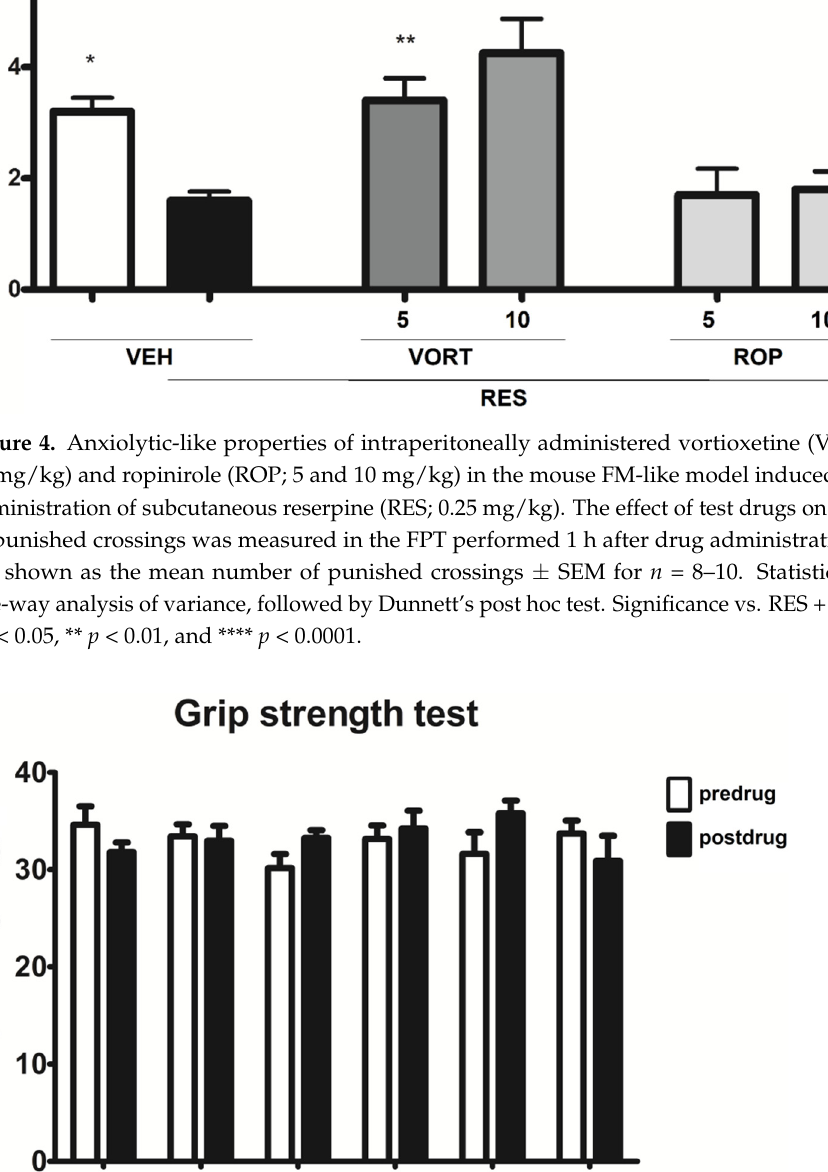
Figure 5. Effect of intraperitoneally administered vortioxetine (VORT; 5 and 10 mg/kg) and ropinirole (ROP; 5 and 10 mg/kg) on the muscle strength in the mouse FM-like model induced by a 3-day administration of subcutaneous reserpine (RES; 0.25 mg/kg). The effect of VORT and ROP was measured in the grip strength test carried out 1 h after drug administration. Results are shown as the mean force (expressed in (g)) that evoked the animal’s reaction ± SEM for n = 10. Statistical analysis: repeated-measures analysis of variance, followed by Tukey’s post hoc comparison. Significance vs. RES + VEH group at the respective time point of testing: p >